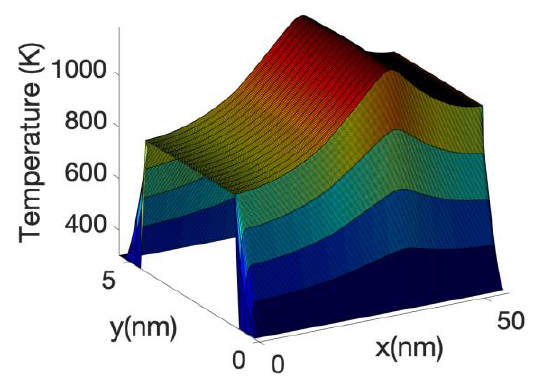
Figure 18. Lattice temperature profile for Vg = 0.6 V considering Joule self-heating. This figure is to be compared with figure 17. The peak temperature is almost twice the value of Figure 17. Indicating an overestimation of power dissipation.